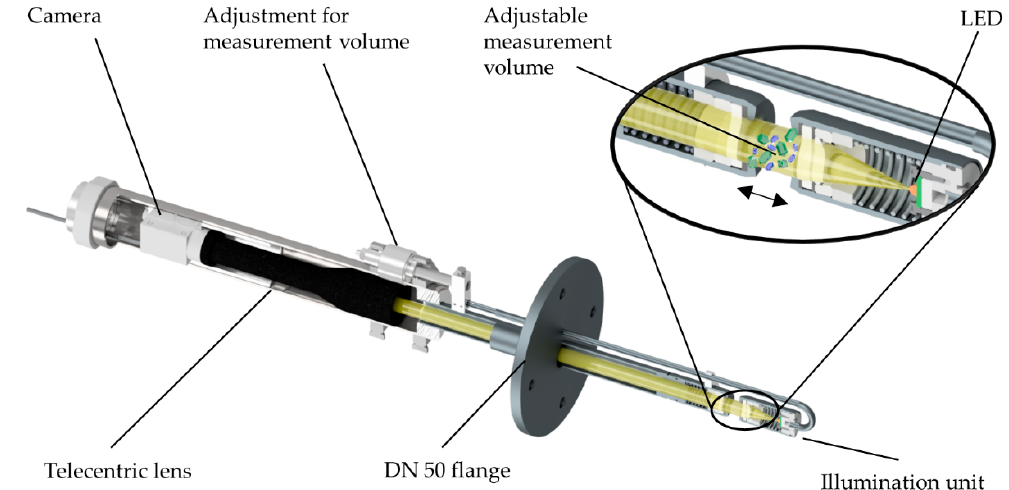
Figure 1. One-sided DN 50 telecentric shadowgraphic probe for laboratory scale published in [56,61].